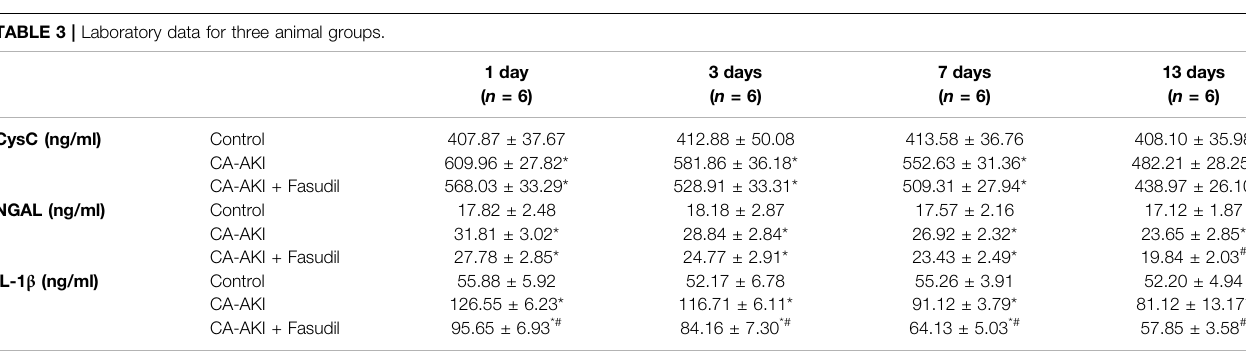
TABLE 3 | Laboratory data for three animal